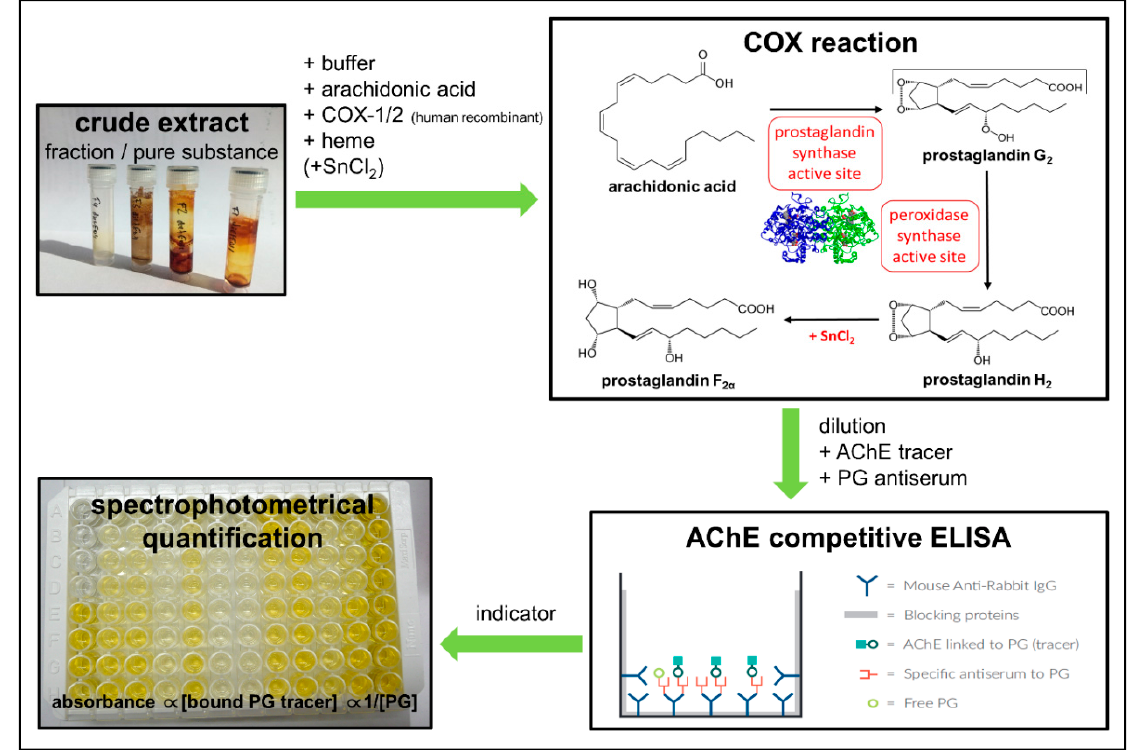
Figure 4. Scheme describing the COX inhibition assay used for screening plant extracts for antiinflammatory activity.